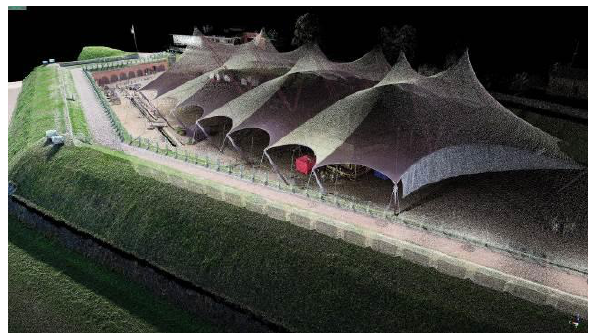
Figure 12. Integration between data, inner bastion and canopy documented with Laser scanner, top and outer bastion documented through Aerial Photometric technique